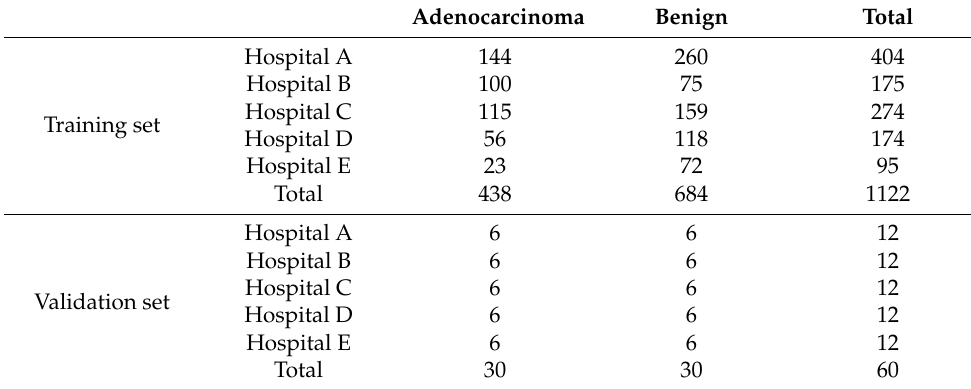
Table 1. Distribution of the WSIs in the training and validation sets.